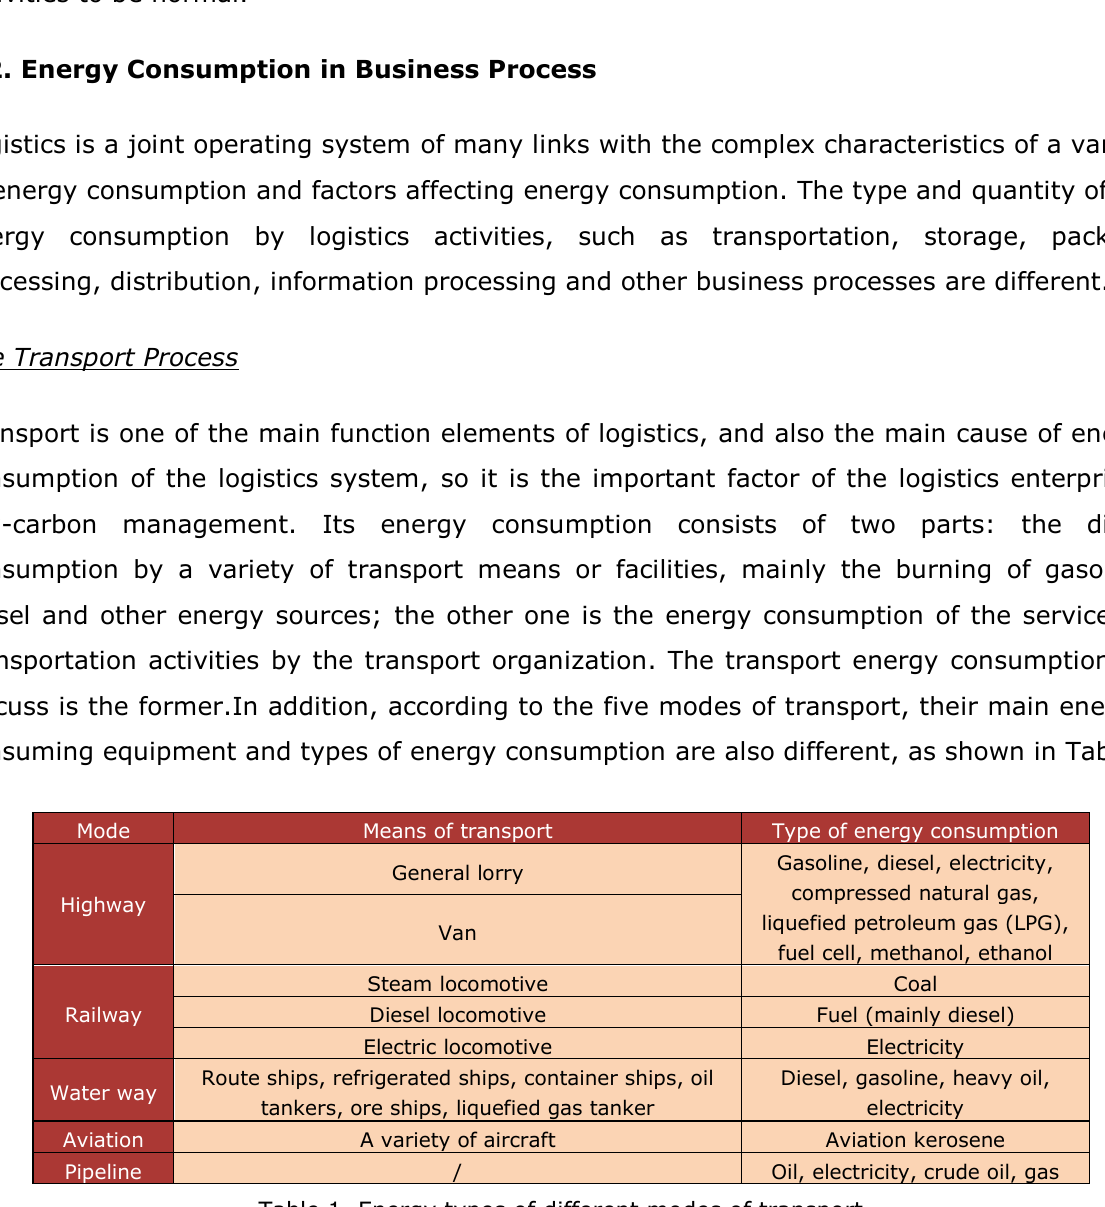
Table 1. Energy types of different modes of